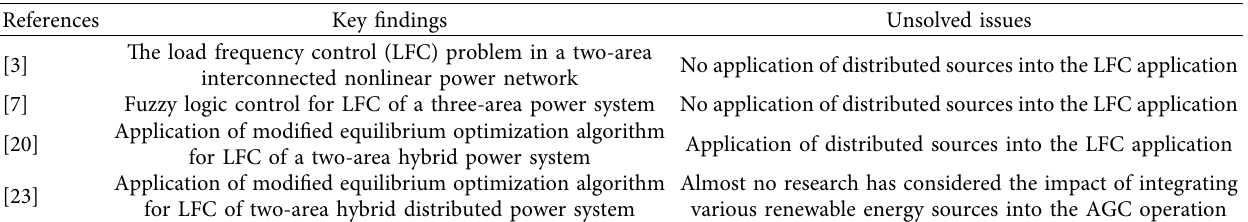
Table 1: Broad literature review.